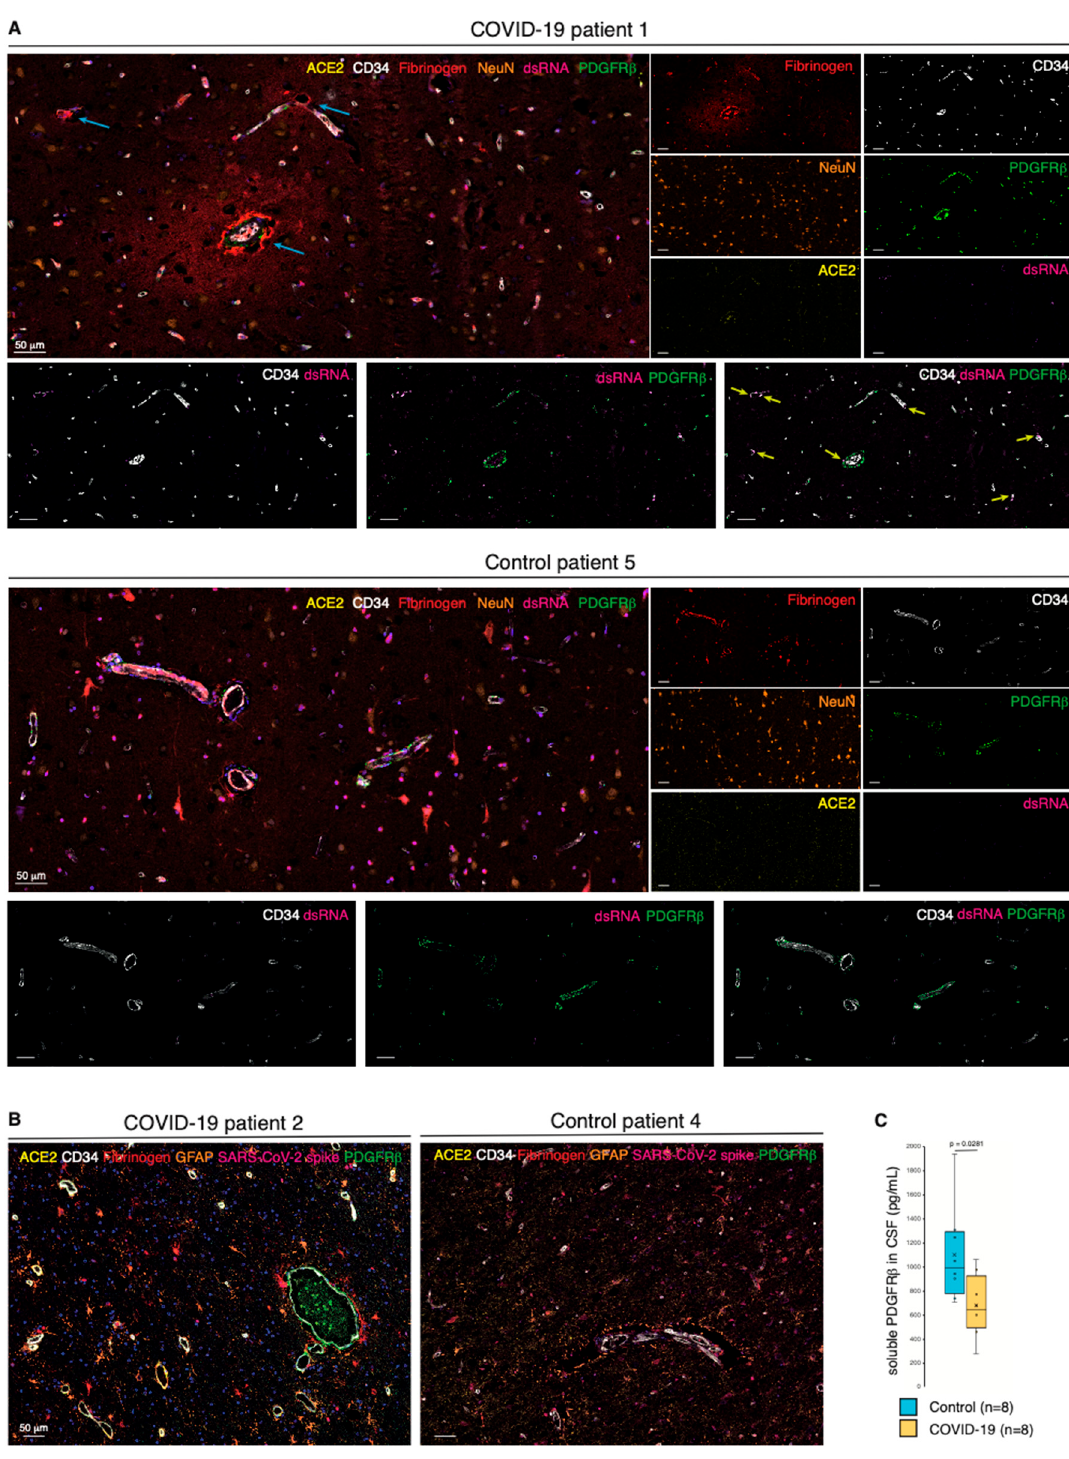
Figure 3. Pericyte infection leads to vascular leakage in the CNS. ( A ) Composite mIHC of the frontal cortex of a COVID-19 patient and a control individual. The fields highlight the fibrinogen halo surrounding leaky blood vessels following SARS-CoV-2 infection. The images depict the neurovascular unit (CD34, PDGFR β , and ACE2), fibrinogen, viral dsRNA, and neurons. The intensity of each OPAL fluorophore is further presented in individual photomicrographs. The cyan arrows indicate fibrinogen leakage; yellow arrows highlight points of converging PDGFR β /dsRNA staining. ( B ) Composite mIHC of the frontal cortex of a COVID-19 patient and a control individual. The fields focus on astrocyte priming as a